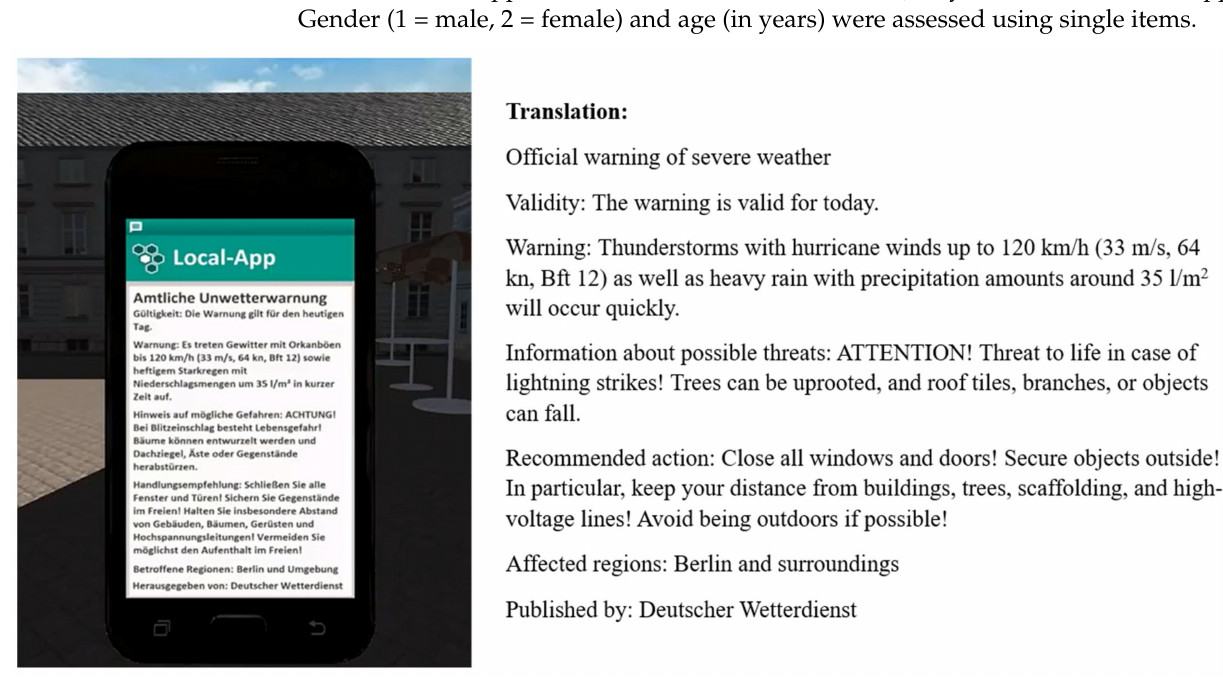
Figure 1. Warning message used at second point of measurement (t2; in German), and English translation of the warning